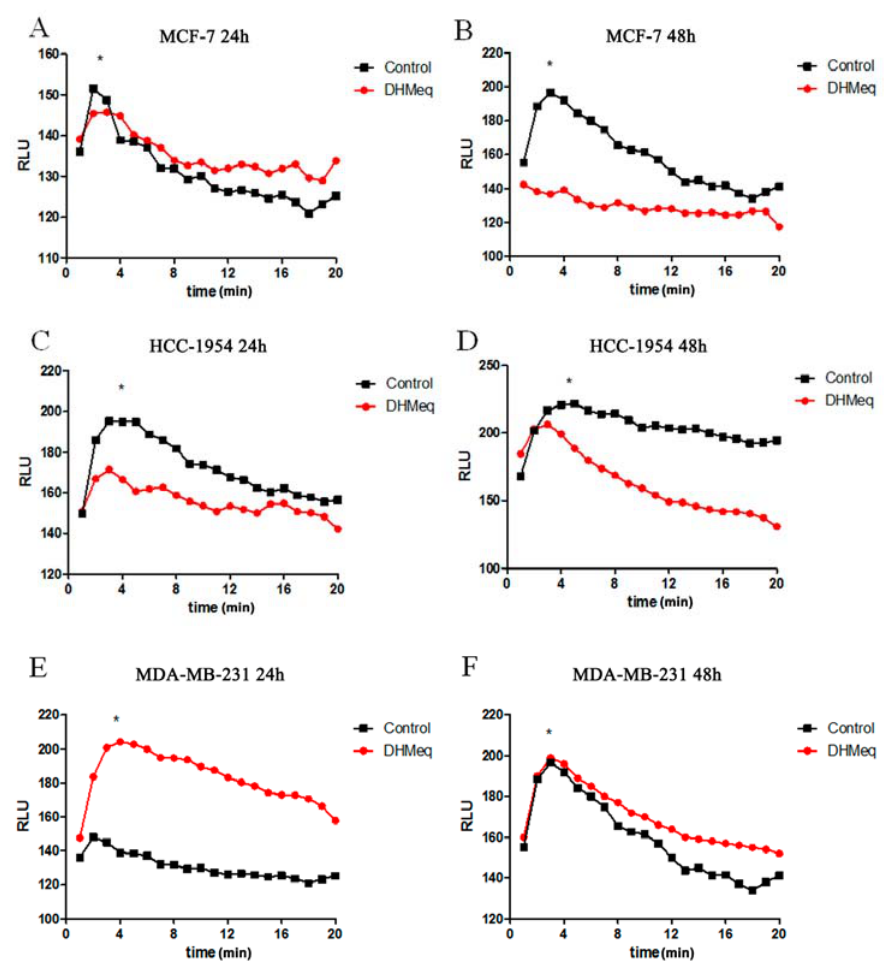
Figure 5. Lipid peroxidation profile. MCF-7 ( A , B ), HCC-1954 ( C , D ) and MDA-MB231 ( E , F ) cells treated or not with NF- κ B inhibitor for 24 or 48 h. Data are expressed as the means. * indicates statistical significance ( p < 0.05). Time (min).